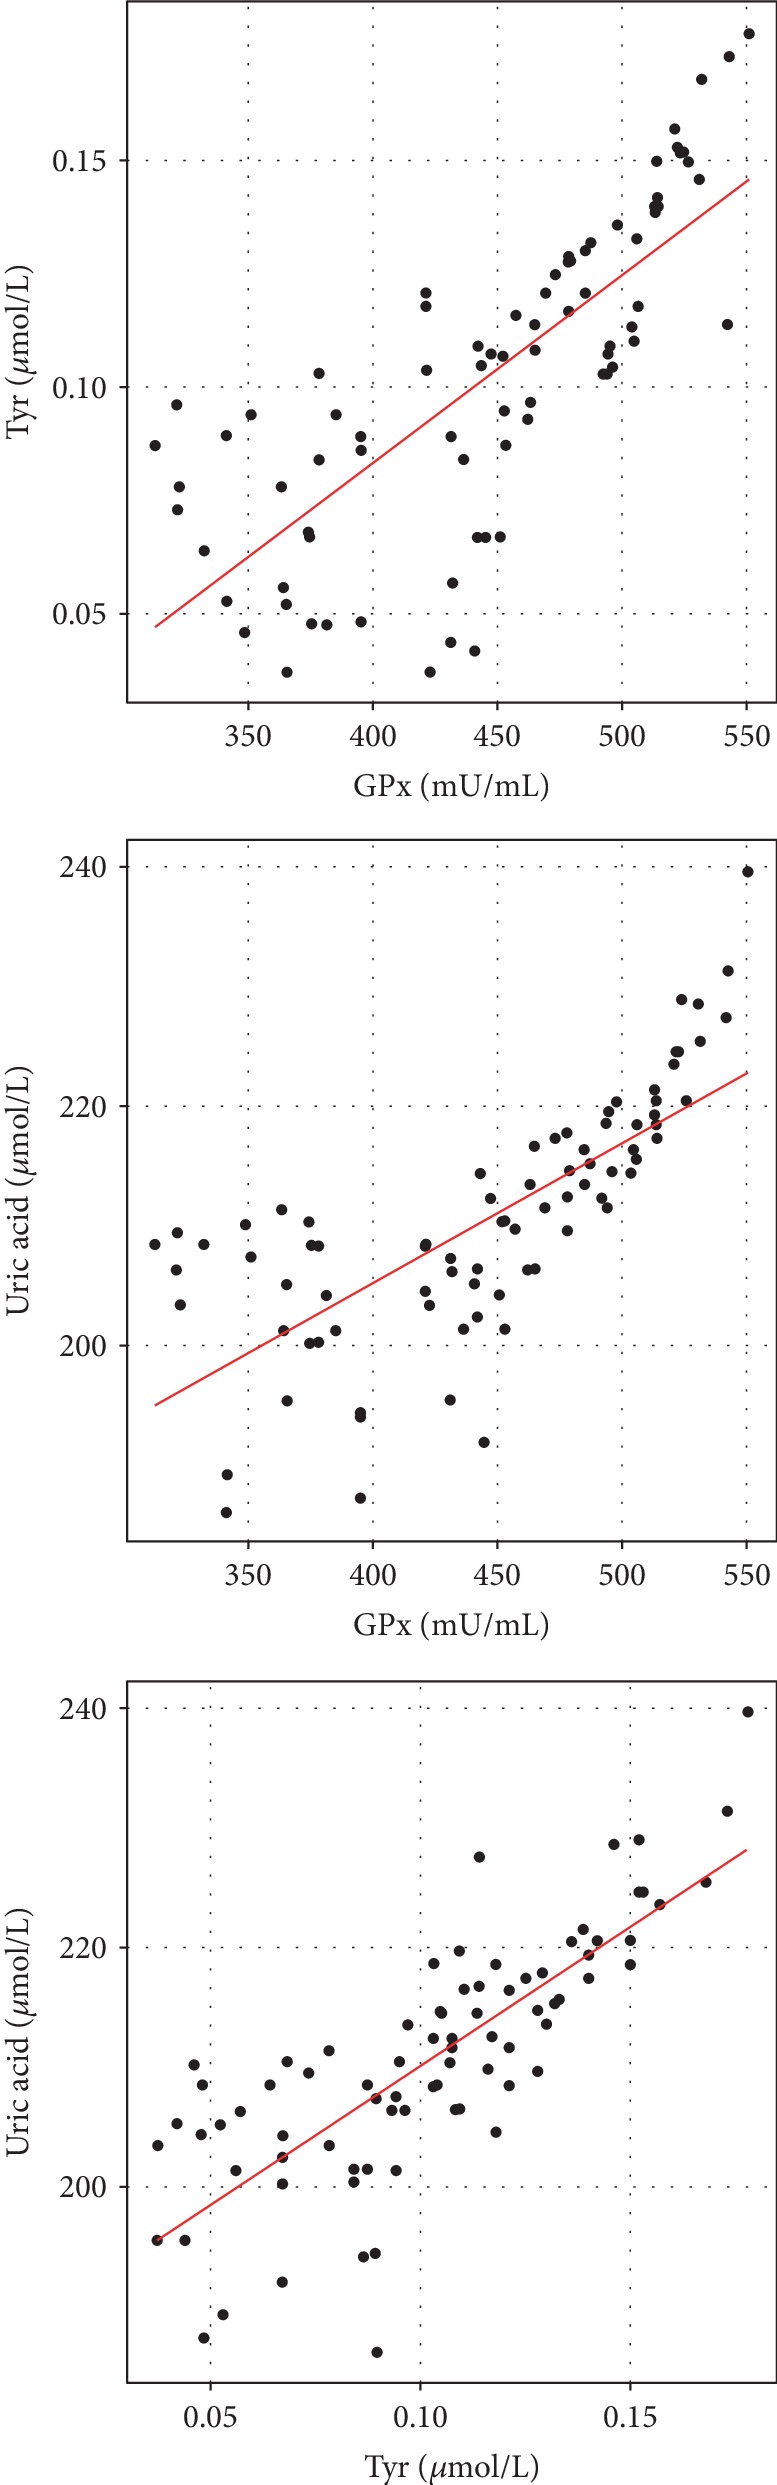
Scatter (correlation) charts depicting the relationships between the studied parameters, i.e., tyrosine, glutathione peroxidase, and uric acid. Individual observations are shown in groups.